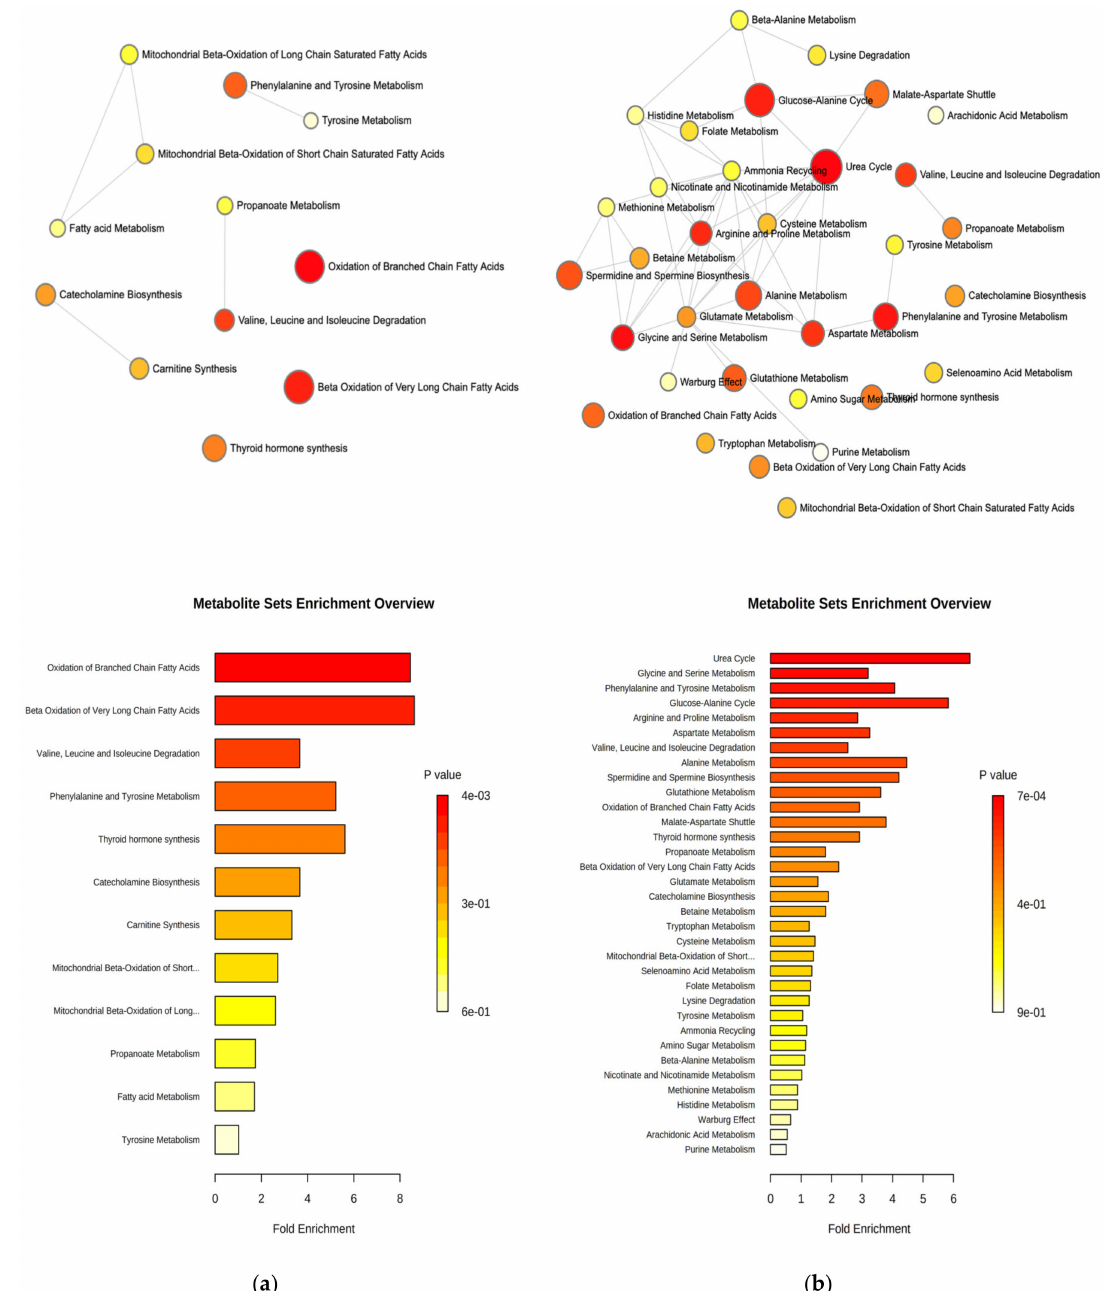
Figure 8. Metabolite set enrichment analysis based on the di ff erentially abundant metabolites identified in the heart ( a ) and liver ( b ) of NAGLU − / −